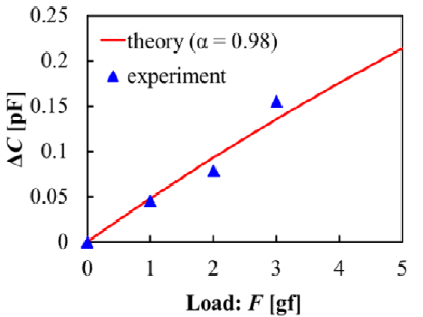
Figure 10. Change in capacitance vs. adding force.